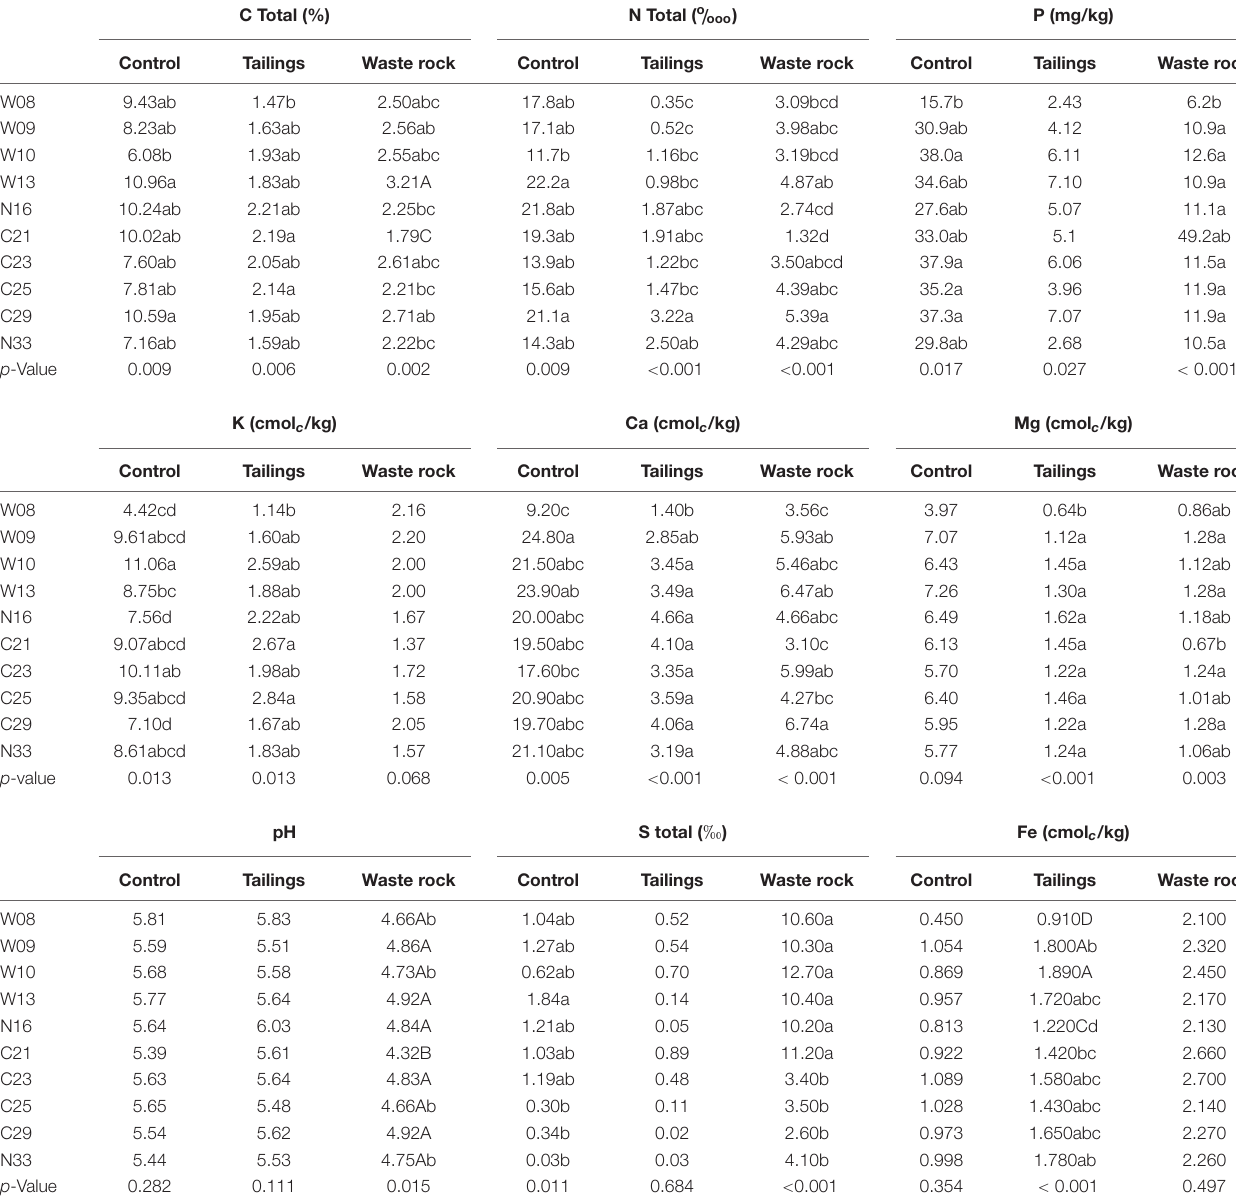
TABLE 2 | Physicochemical properties of substrates after the greenhouse experiment. C Total (%) N Total ( o / ooo